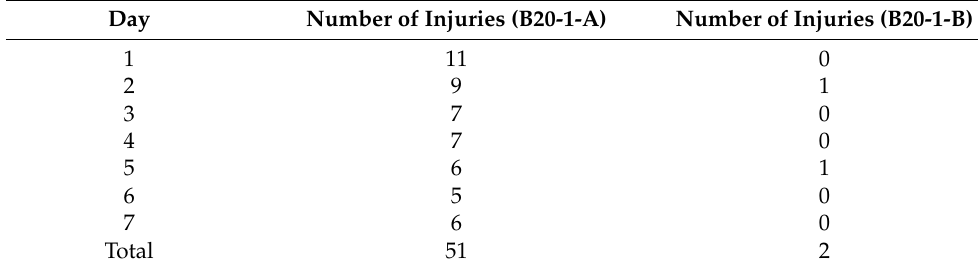
Table 1. The number of injuries for B20-1-A and B20-1-B dumbbells during this